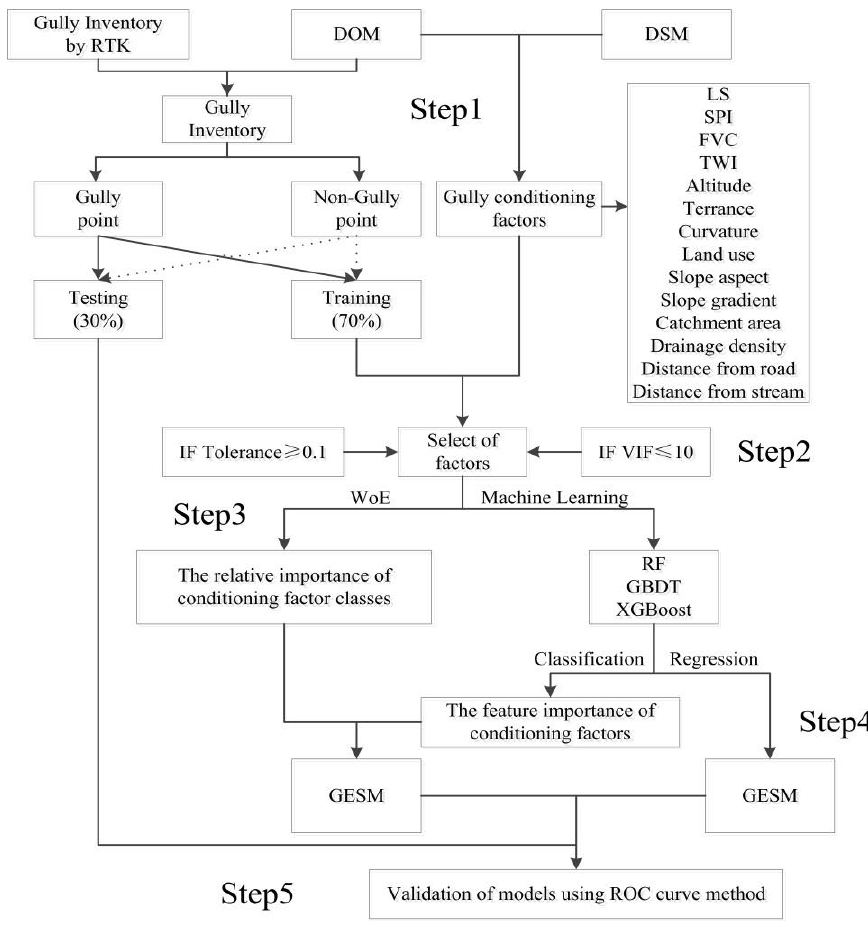
Figure 2. Study flow diagram.